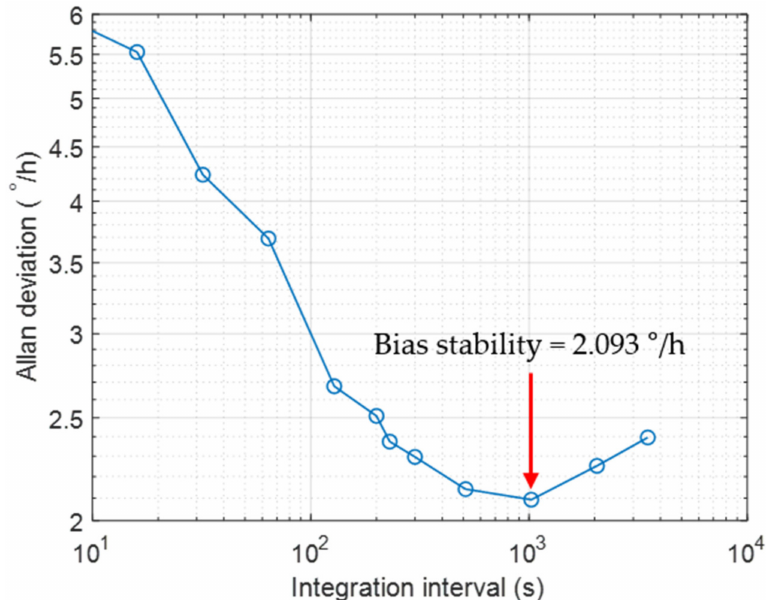
Figure 10. The plot of Allan deviations made with the implemented HRG. The measurements have been made for 2 h at room temperature without temperature control. The bias stability was 2.093 ◦ /h, which corresponds to an industrial-grade